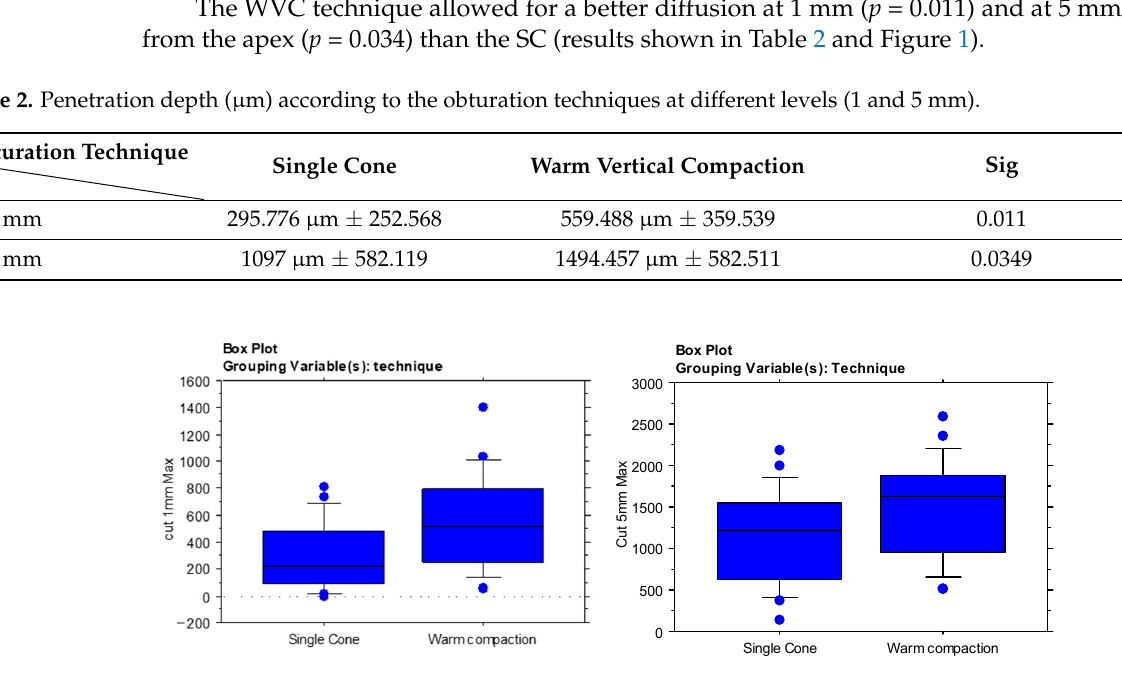
Table 1. Mean penetration depth (µm) of two calcium silicate-based sealers.